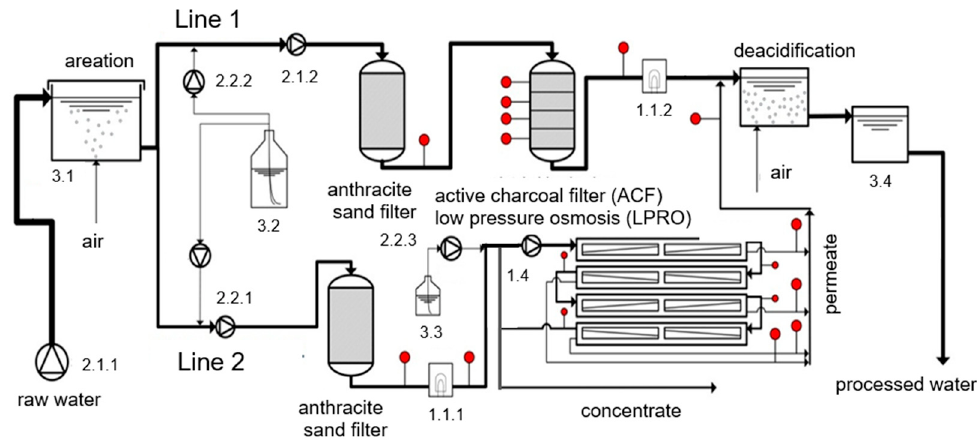
Figure 2. Schematic illustration for the employed pilot plant comprising two treatment lines, ACF (line 1) and LPRO (line 2); red dots refer to sampling points; descriptions of the sampling points are provided in supplementary data (Table S3).